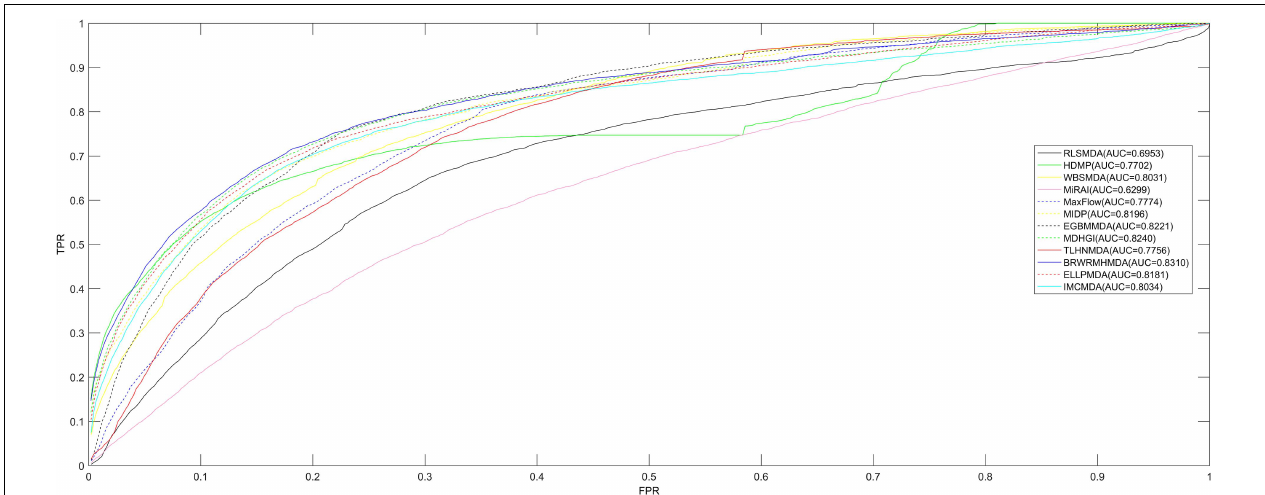
FIGURE 2 | Flowchart of BRWRMHMDA to prioritize candidate miRNAs for diseases. Through employing BRWR on the established heterogeneous networks, final scores p ∞ of candidate miRNAs predicted for each disease would be gotten after some